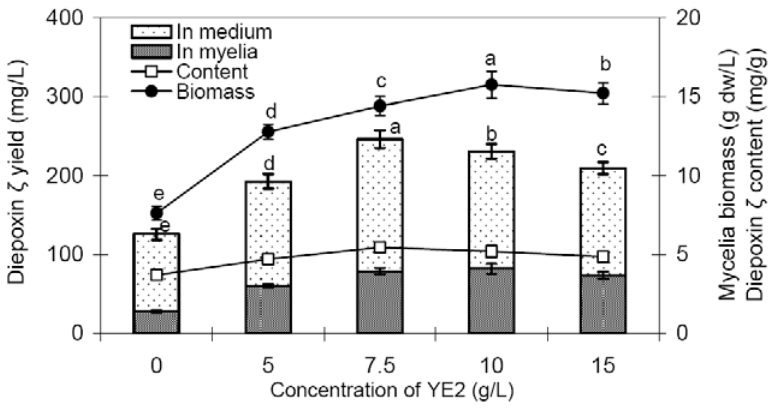
Figure 5. Effects of YE2 applied to the medium on day 3 on mycelia growth and diepoxin ζ production in liquid culture of endophytic fungus Dzf12. The period of culture was 13 days; The error bars for standard deviations, n = 3; Different letters ( i.e ., a-e) indicated significant differences among the treatments at p = 0.05 level. Only the significant differences of the mycelia biomass and total diepoxin ζ yield were